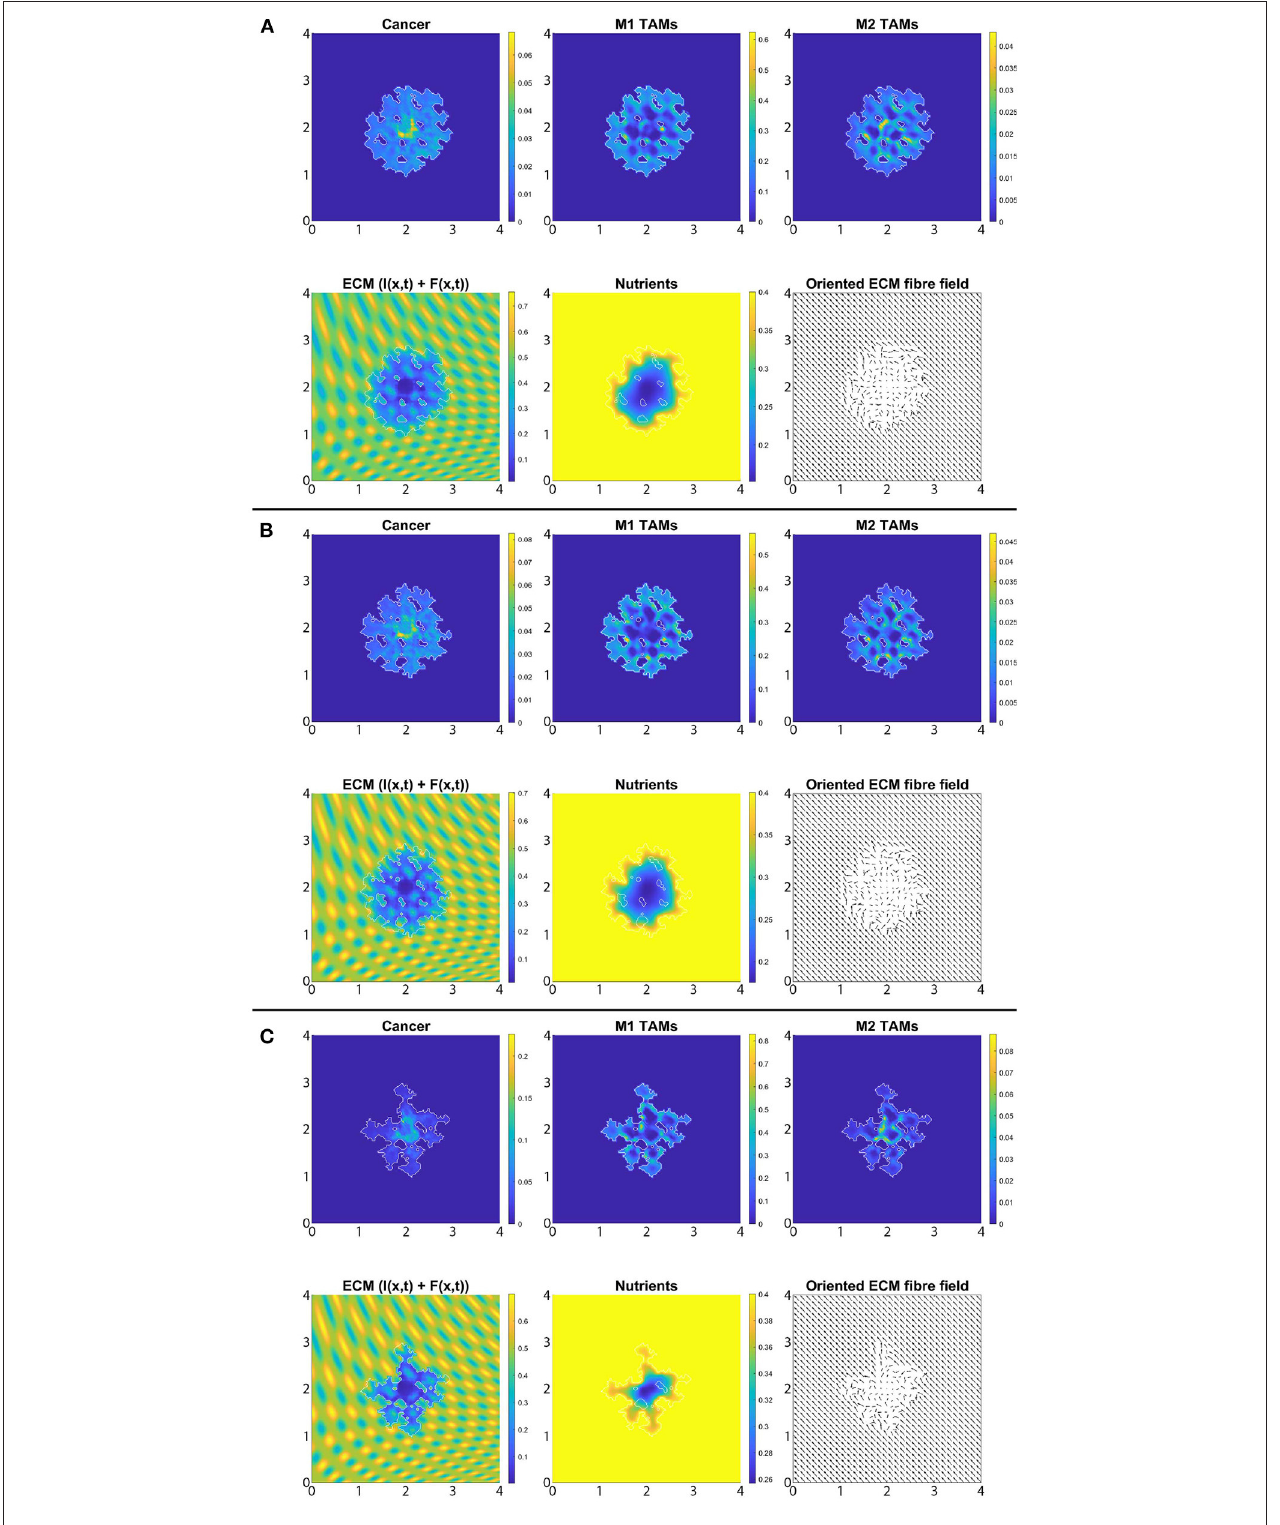
FIGURE 8 | Simulation with re-polarisation domain (cid:127) p ( t , 1 x ) and with starting time t p = 0 at the final time 50 1 t . (A) β = 0.75, (B) β = 0.7875, and (C) β = 0.825.